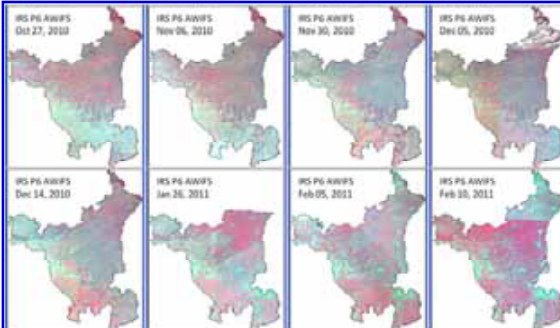
Fig. 3: Multi-date AWiFS Mosaic Images (Dates+5days) over Haryana state.